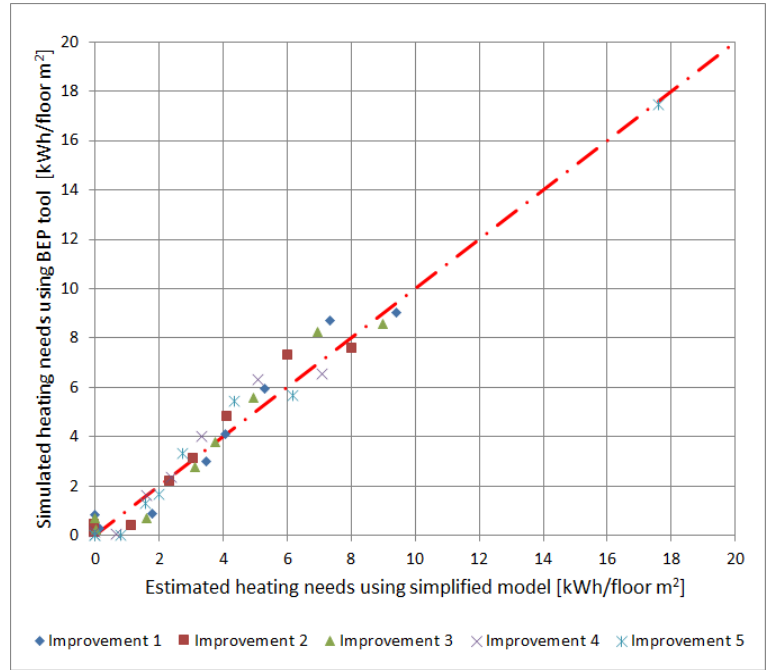
Figure 9. Comparison of results from the simulation and the estimated model with heating needs identified.